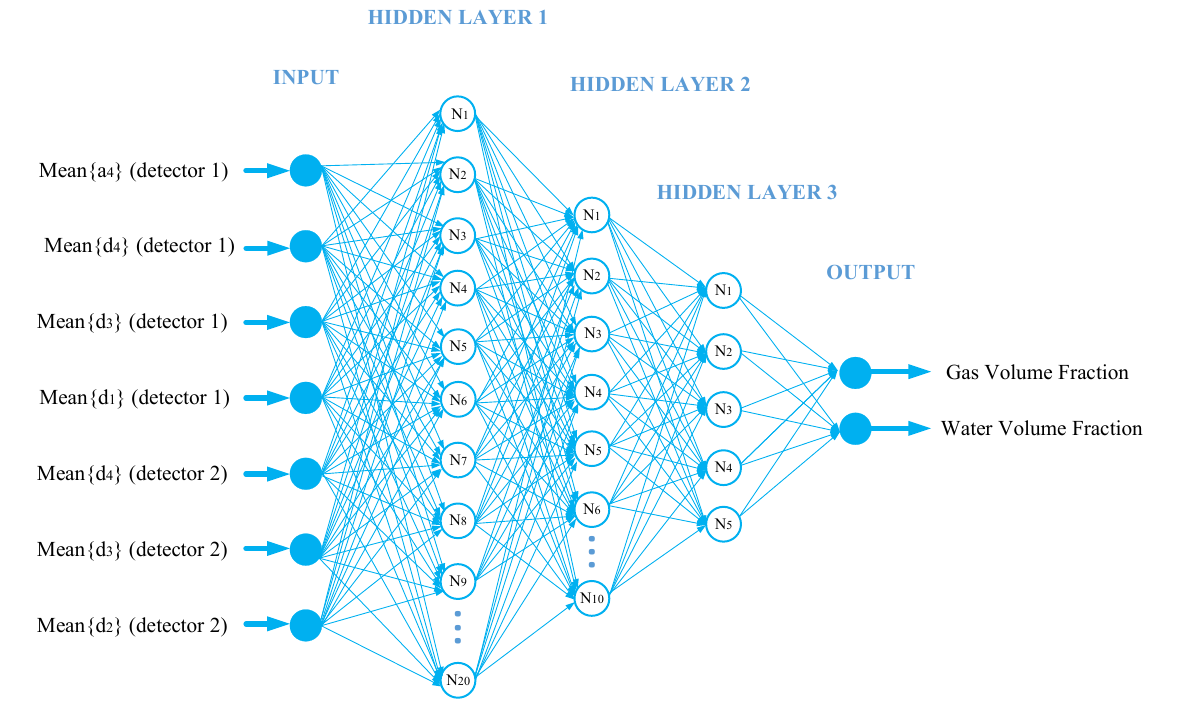
Figure 8. The implemented neural network structure to determine the volumetric percentages of gas and water.